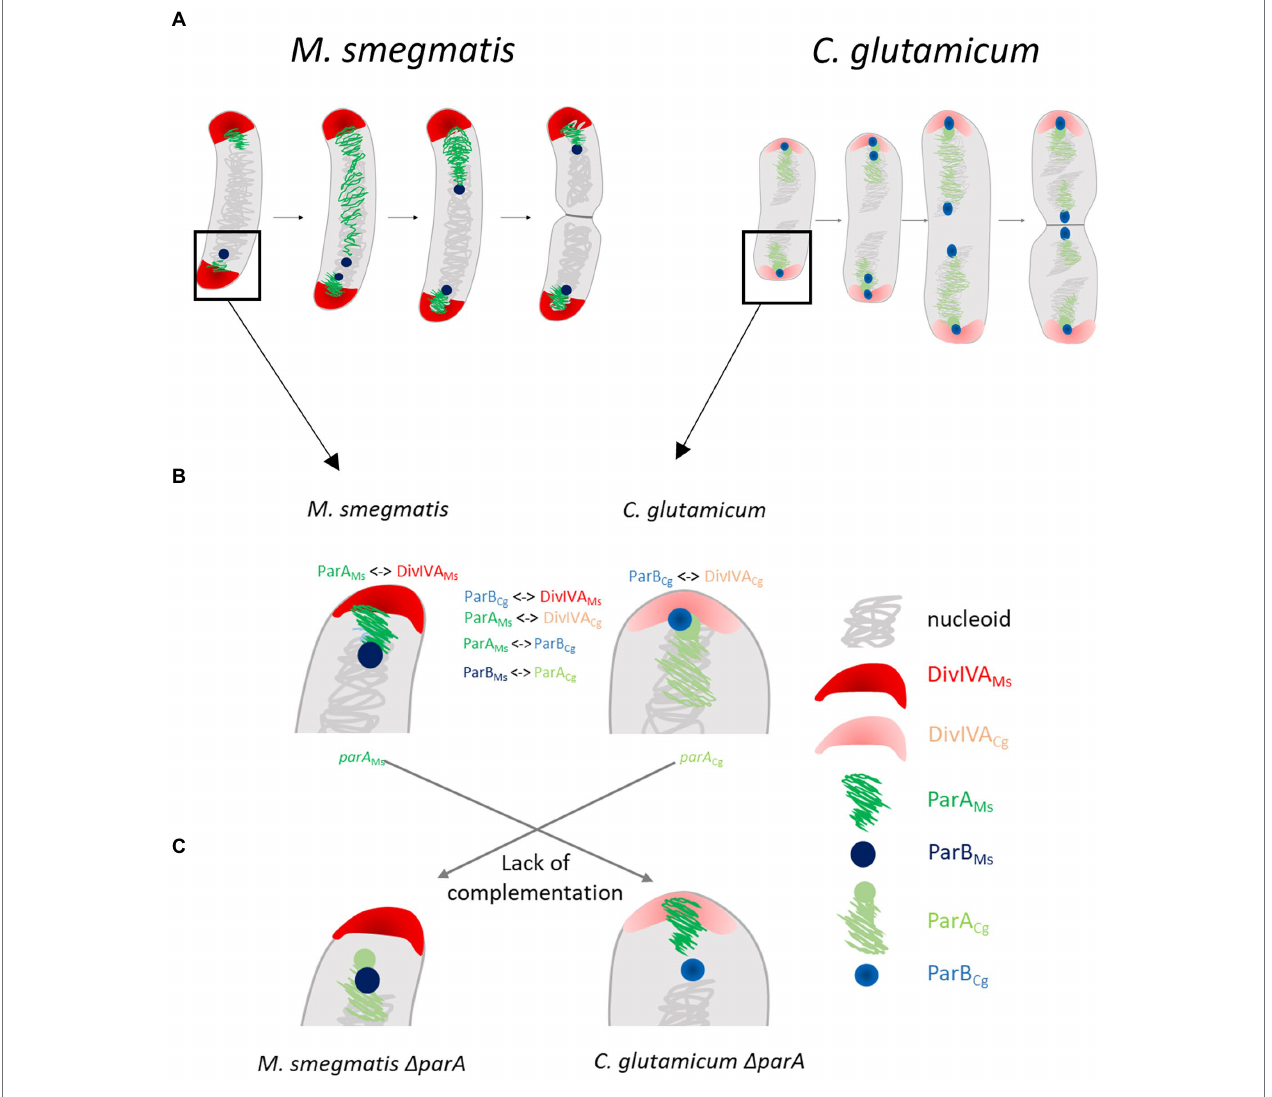
FIGURE 7 | The species specific interactions of segregation and polarly localised proteins in Actinobacteria are critical for efficient chromosome segregation and may be linked with the different oriC positioning. (A) Scheme of differences in oriC positioning in closely related Mycobacterium smegmatis and Corynebacterium glutamicum cells which undergo non-overlapping (1 or 2 oriCs in cell in some distance from the pole) or overlapping rounds of replication (2 or 4 oriCs , polarly localised), respectively. ( B) The interactions of segregation proteins and polar partner proteins (marked with symbol < − >) and detailed oriC positioning (polar or in distance to the pole). (C) The lack of complementation of parA deletion phenotype with heterologous parA